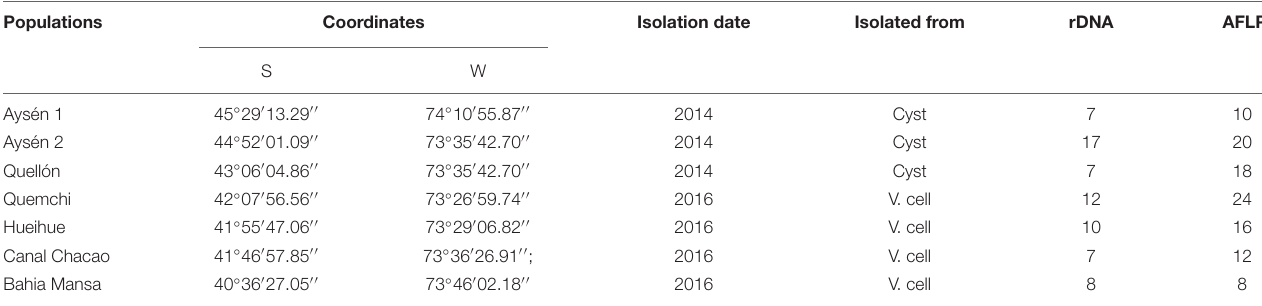
TABLE 1 | Alexandrium catenella samples information. Populations